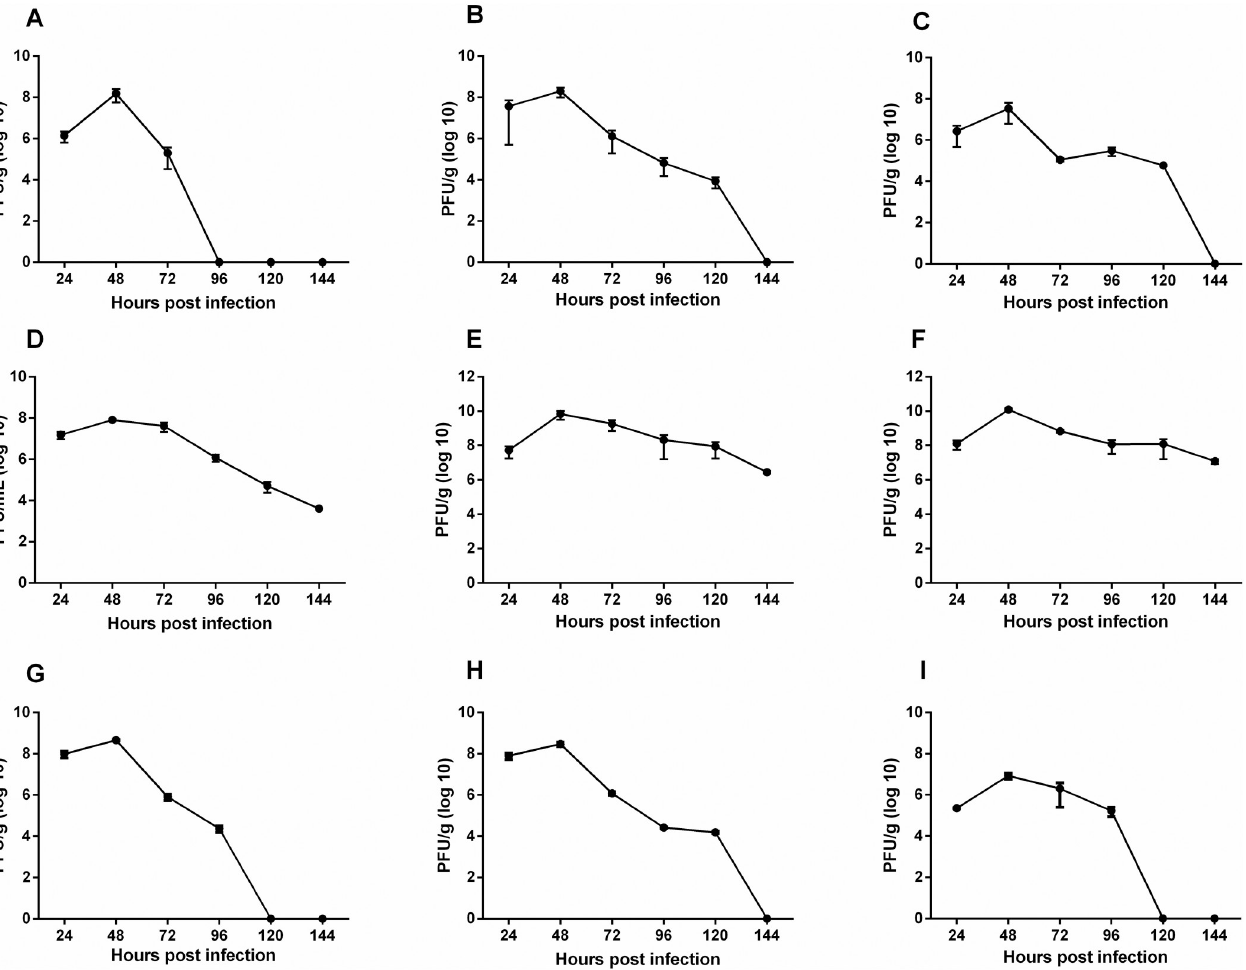
Fig 13. MAYV load on organ and tissues. 15-day old Balb/c mice were infected below the forelimb with 1.25x10 7 PFU. At 24, 48, 72, 96, 120 and 144 hpi, liver (A), spleen (B), heart (C), serum (D), right and left ankles E and F), right and left quadricep muscles (G and H) and eyes (I) were harvested and homogenized, and the amount of infectious virus present was quantified by plaque assay on Vero cells. N = 3